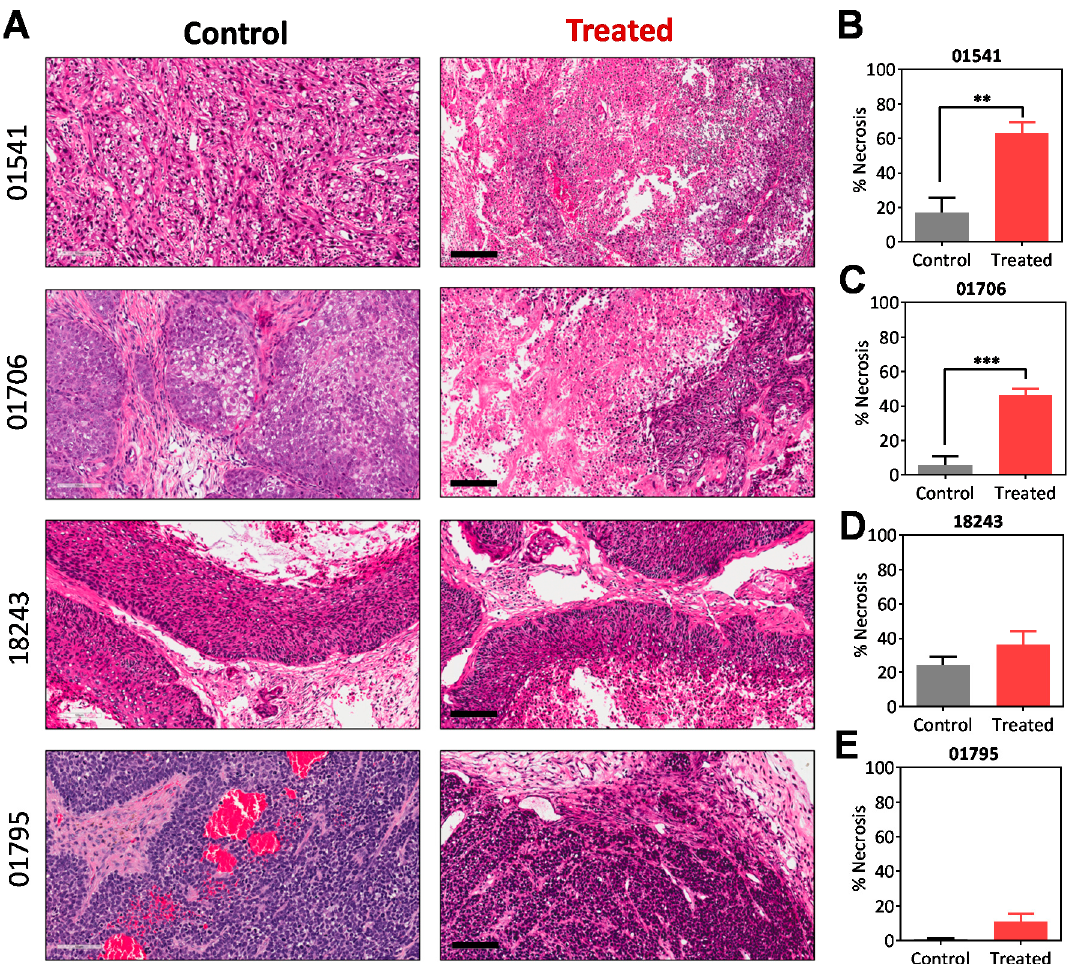
Figure 4. Pathologic response of p16 − PDX and p16+ PDX to EPC2407. ( A ) Hematoxylin and eosin (H&E) stained tumor sections from control and vascular disrupting agent (VDA) treated p16 − PDX (01541, 01706) and p16+ PDX (18243, 01795). Images are shown at 20× magnification, scale bar represents 100 µ m. Corresponding bar graphs of tumor necrosis (%) for control and treated tumors ( n = 4–5 tumors per PDX; n = 3–4 fields per tumor) for all 4 PDX models are shown on the right ( B – E ). ** p < 0.01; *** p < 0.001.